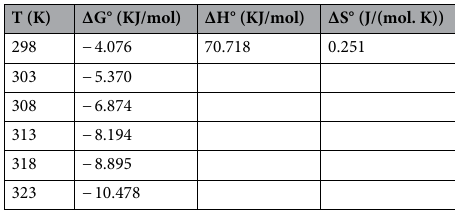
Table 6. Thermodynamic parameters of As(V) adsorption on amino-MIL-68(Al).